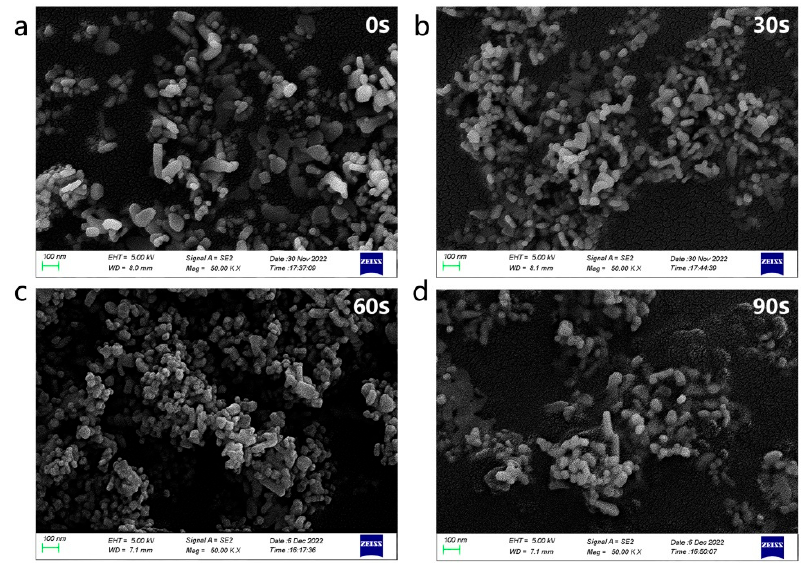
Figure 4. FESEM images of NP surfaces plasma-treated for different durations: ( a ) 0 s; ( b ) 30 s; ( c ) 60 s; and ( d ) 90 s.